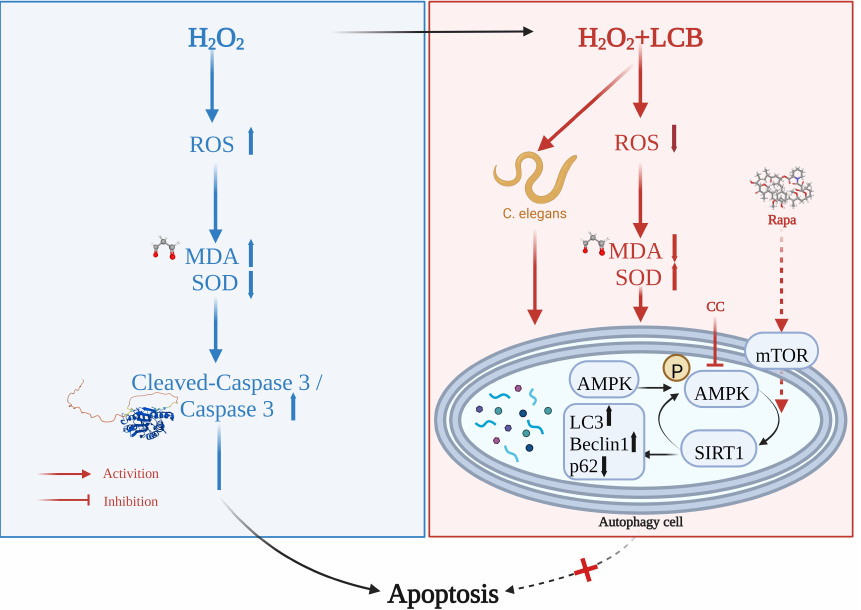
Figure 9. Schematic diagrams depicting the autophagic protective effects of LCB against H 2 O 2 - induced cell apoptosis via the AMPK/SIRT1 autophagy signal pathways. CC, Compound C; Rapa, rapamycin; ROS, reactive oxygen species; MDA, malondialdehyde; SOD, superoxide dismutase. H 2 O 2 is a reactive oxygen molecule that is involved in the pathogenesis of many neu- rological diseases and is commonly used as an inducer of oxidative damage and apoptotic cell death in cellular models. Excessive production of free radicals can lead to cellular damage and cause aging and dysfunction of the human body [24]. With the properties of high oxygen demand and metabolic rate, and a relatively low antioxidant defense system, brain tissue is more vulnerable to free radical attack than any other tissues or organs